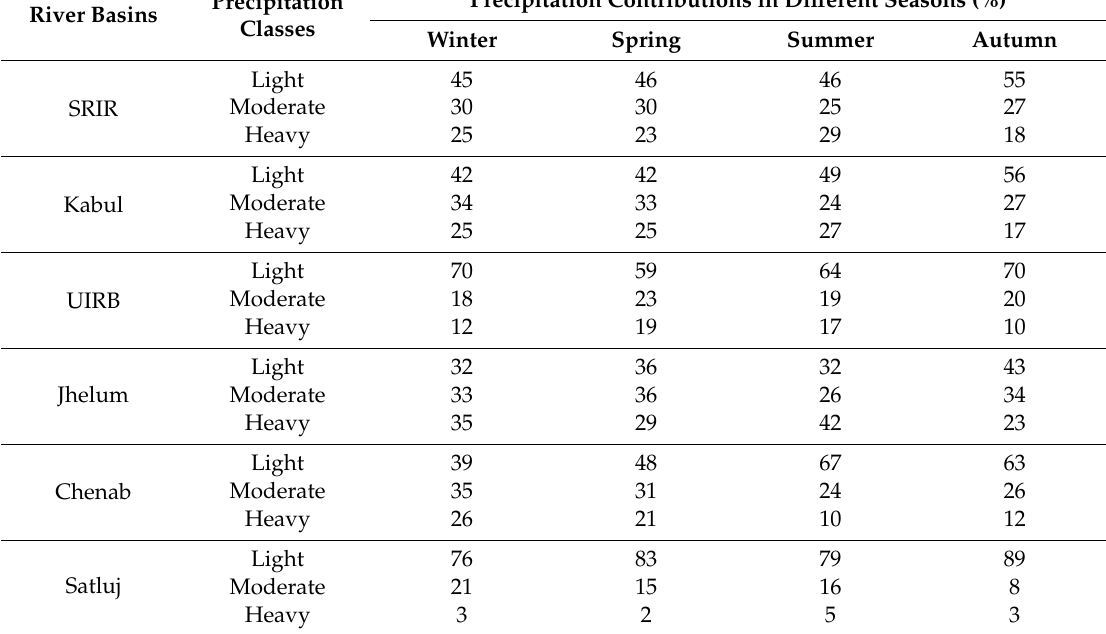
Table 3. Contributions of di ff erent precipitation